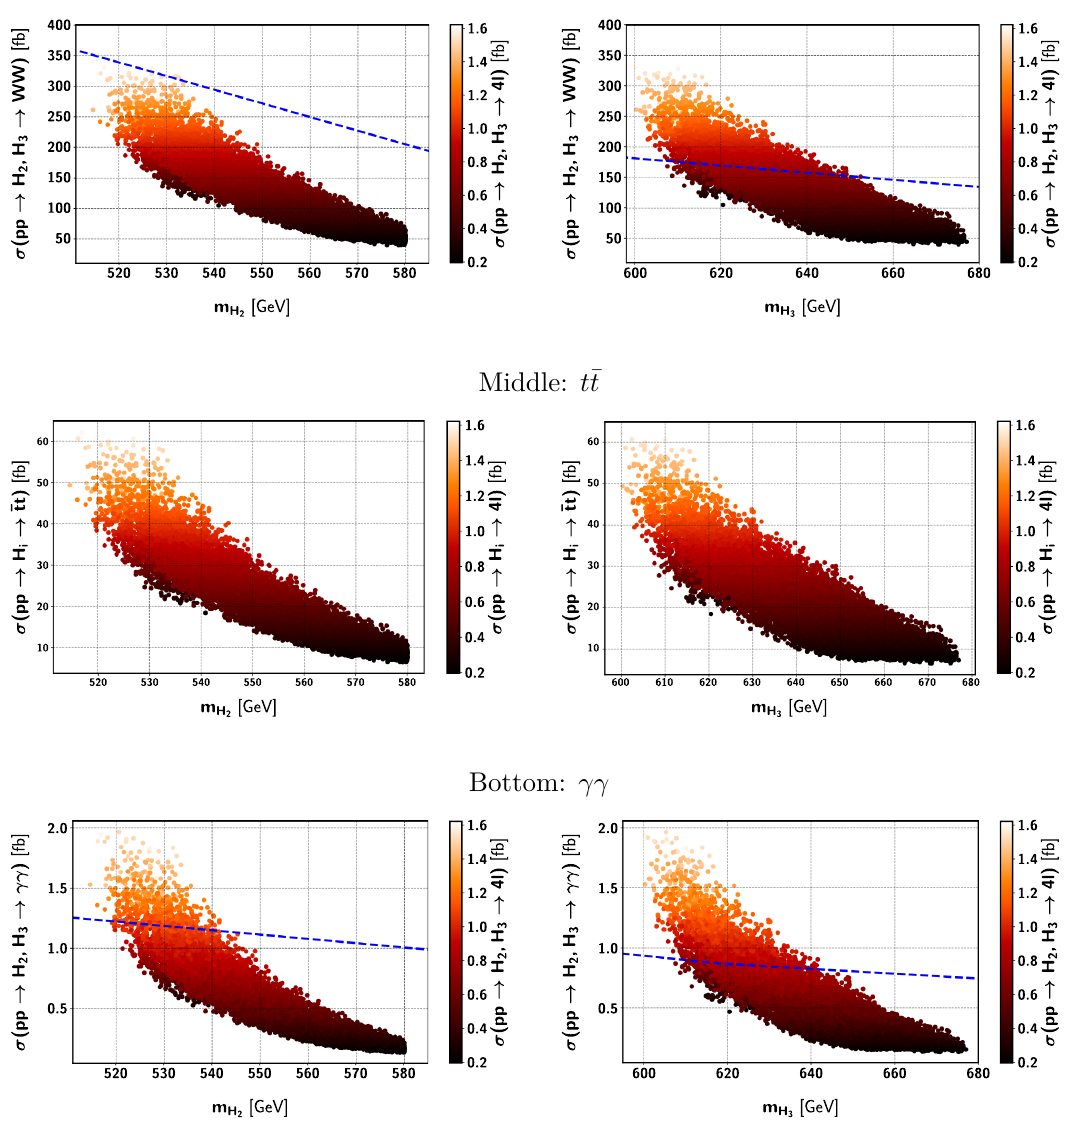
Figure 3 . Results from a very fine-grained parameter space scan within the class of THDMs with CP violation and type I Yukawa structure (cf. [24]). Shown points feature masses m H and inclusive i cross sections σ pp → H within the 90% Bayesian confidence limit of the best-fit point. The left 2 ,H 3 → 4 ‘ and right panels are for H 2 and H 3 , respectively. Top panel : showing the W + W − final state with the blue dashed line denoting the 90% upper limit on the semileptonic cross section from ATLAS [8] for comparison. Middle panel : showing the t ¯ t final state. Bottom panel : showing the γγ final state with the dashed blue line denoting the 90% upper limits from ATLAS